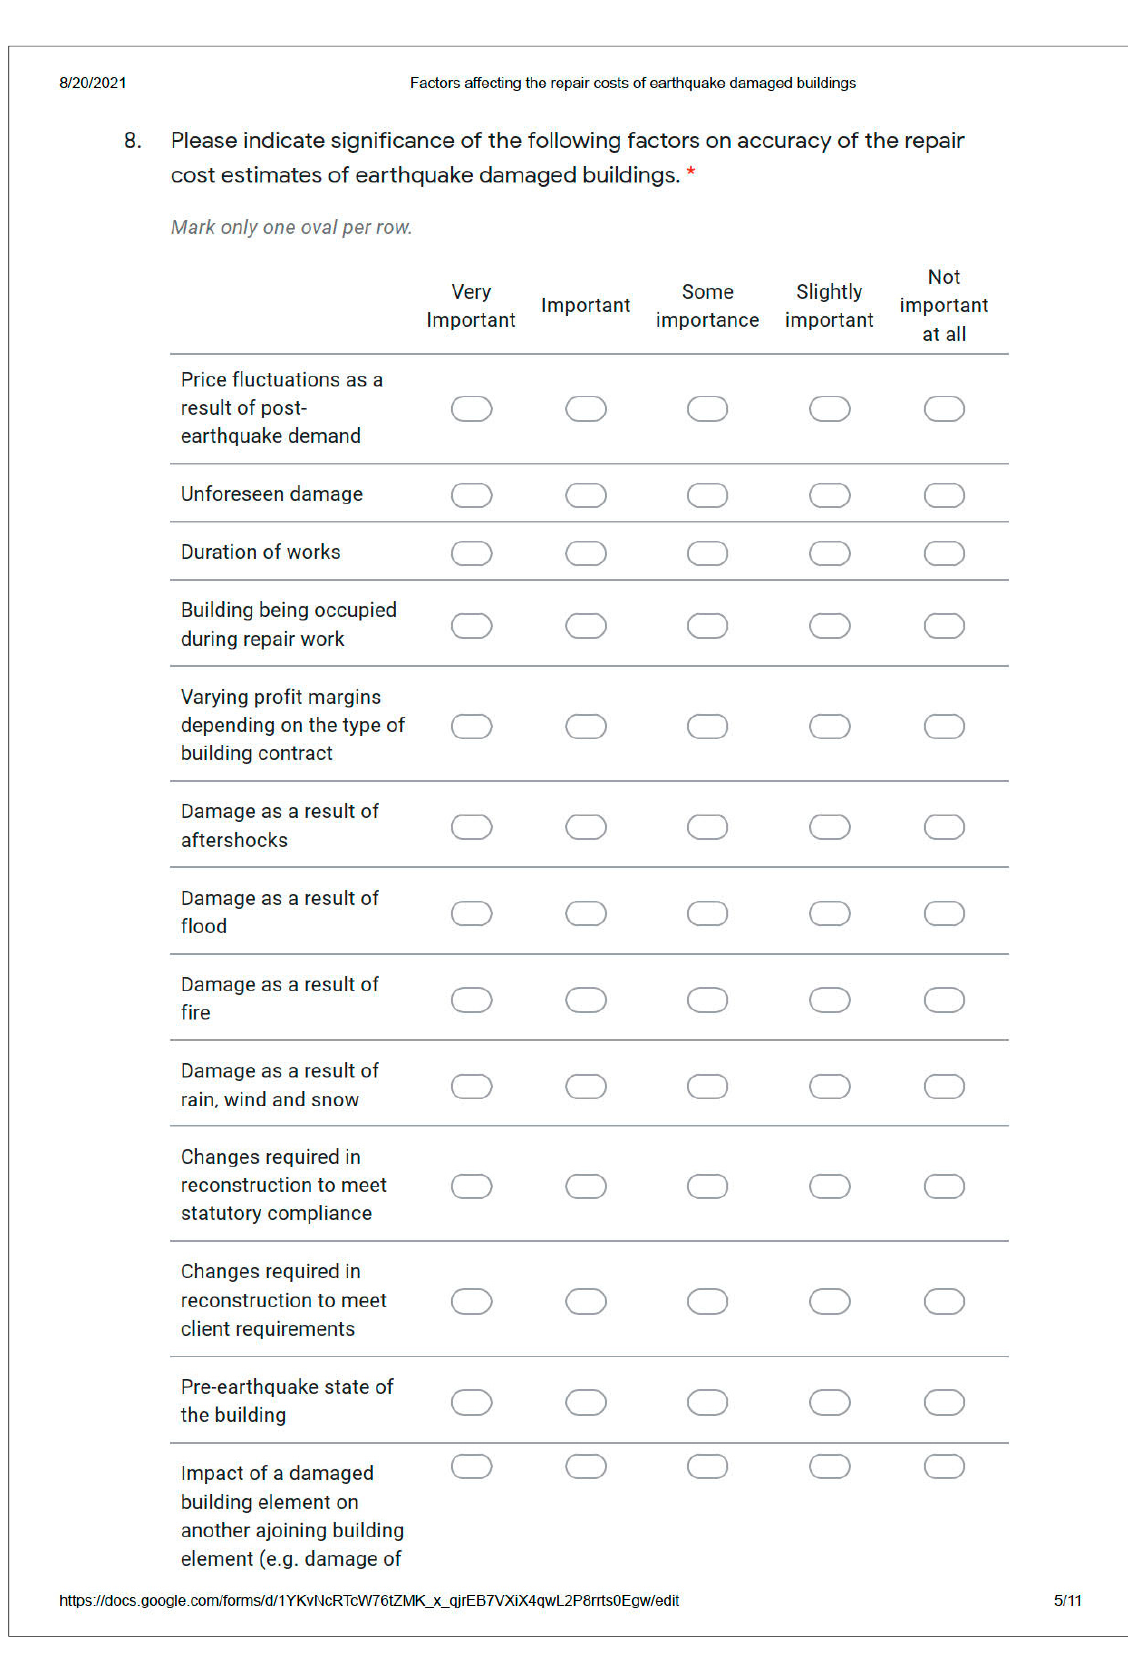
Figure A4. Questionnaire design (sample 4).